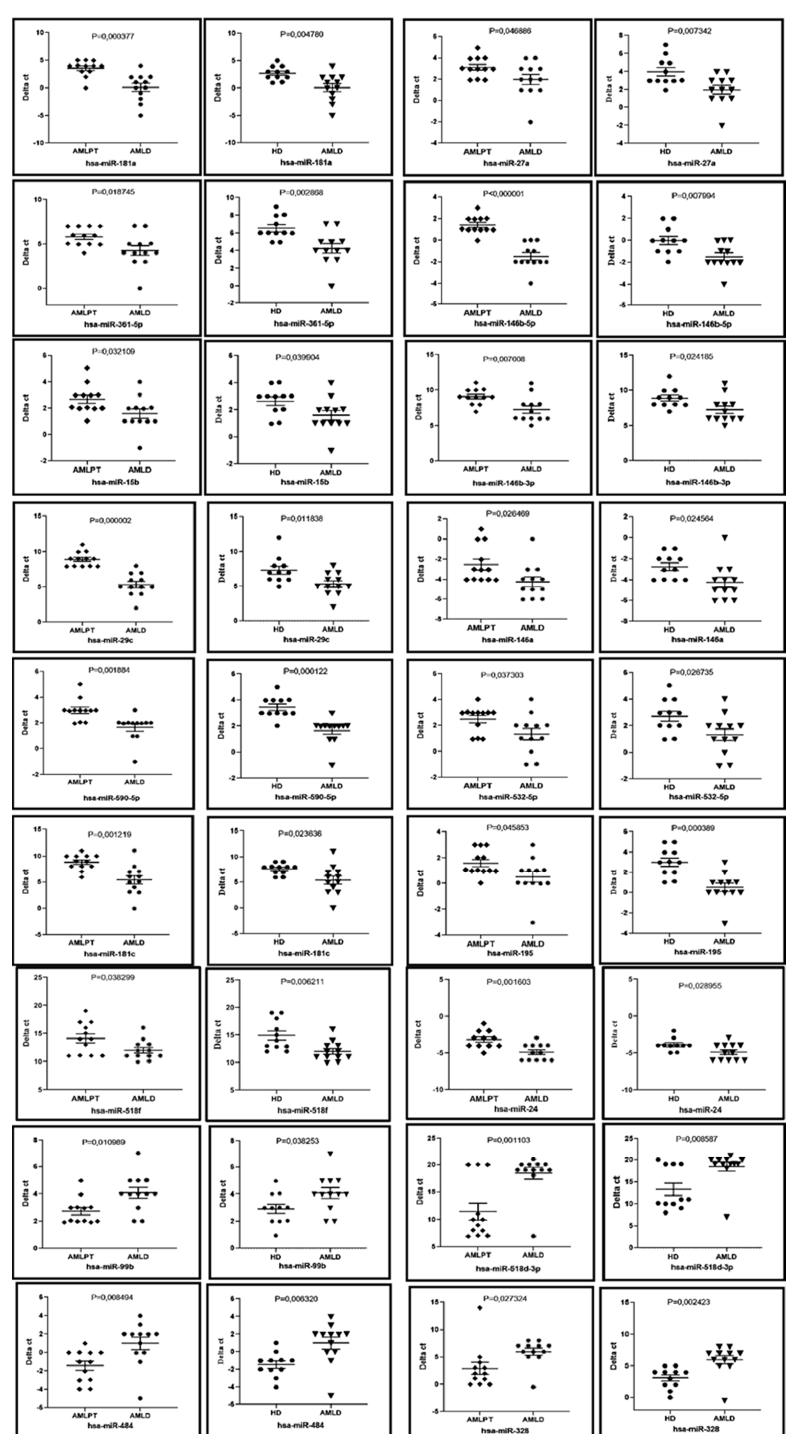
Figure 5. Prognosis value of AML bone marrow circulating miRNAs related to remission after treatment. Correlated differentially expressed miRNAs between AMLD vs. AMLPT patients and AMLD patients vs. HD. The expression dot plot curves reflecting the correlated di ff erentially expressed bone marrow circulating miRNAs in AML patients at diagnosis ( n = 12) compared to both healthy donors ( n = 11) and the same patients in relative remission (blast < 5%) post treatment ( n = 12). AMLD: AML patients at diagnosis. HD: Healthy donors. AMLPT: AML first complete remission post treatment